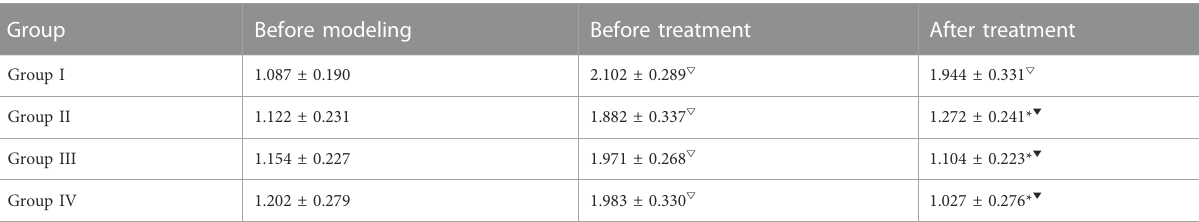
TABLE 6 The FIB content in each group (g/L, ‾ x ± s).